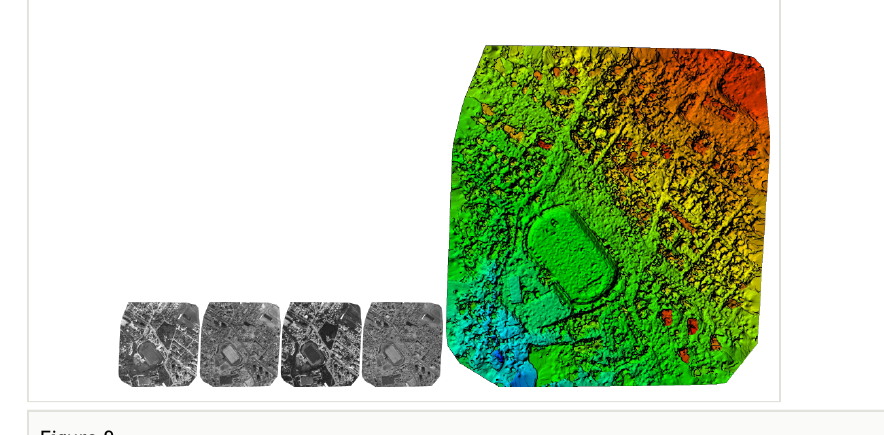
Digital Surface Model of ‘Hunting’ park and city stadium area of Karlovo.